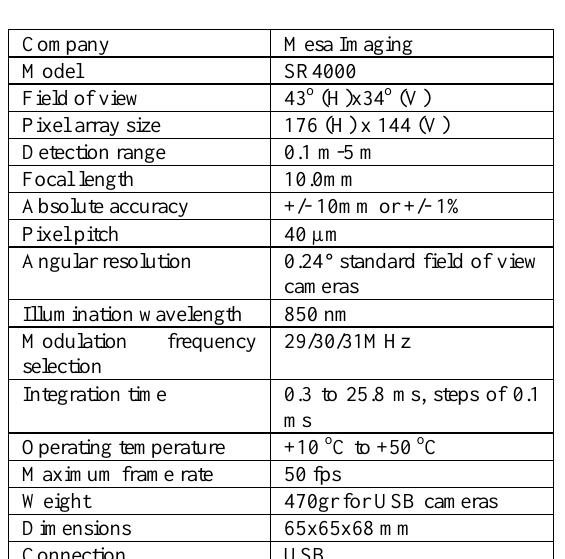
Figure 3. Depth image [legend unit is